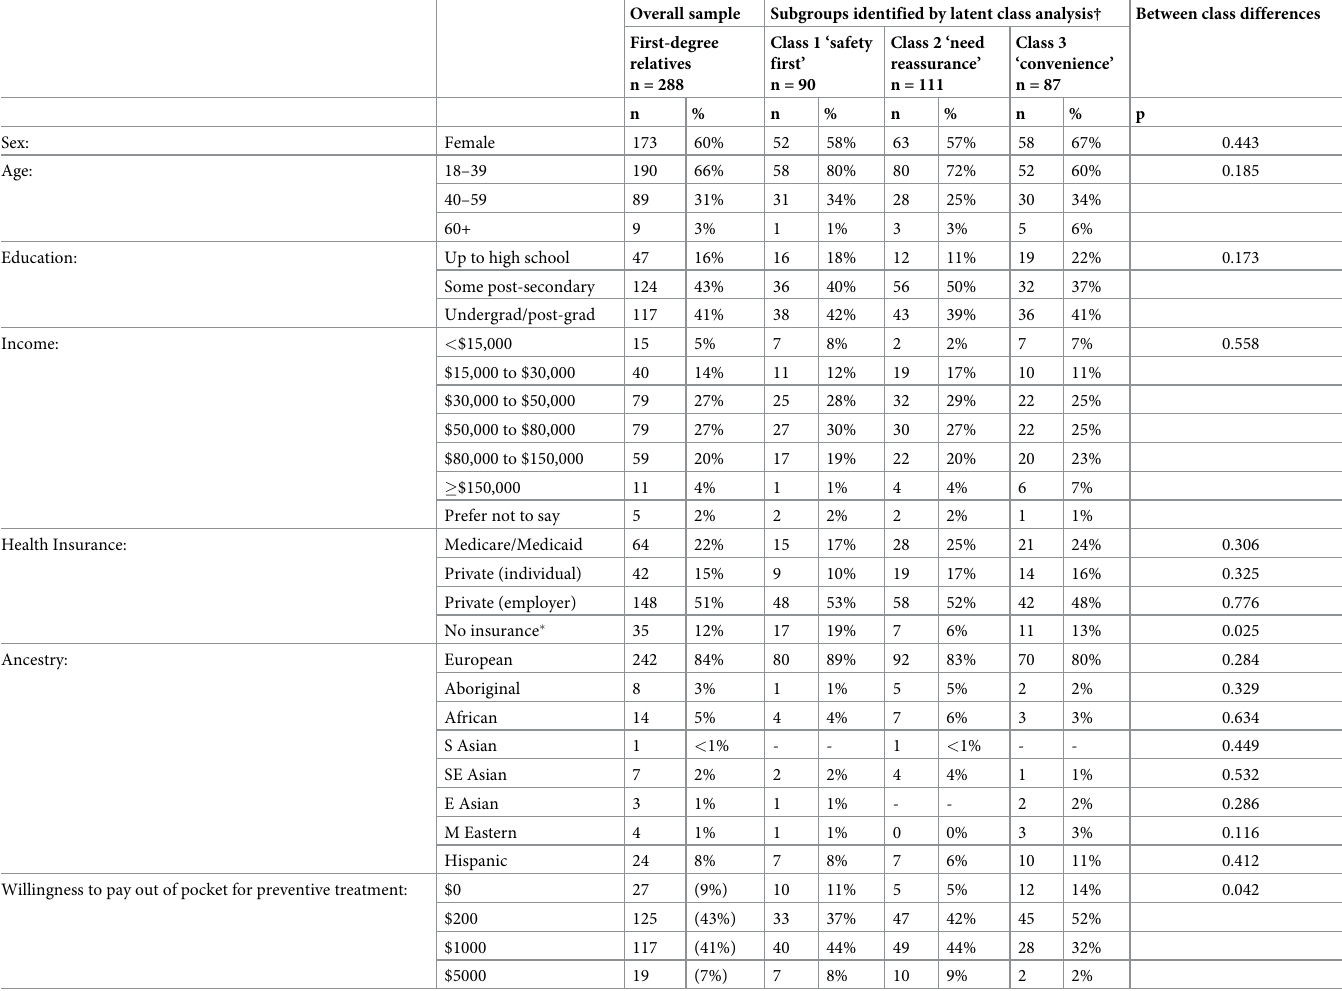
Table 3. Participant characteristics of the overall sample and latent classes of respondents within the overall